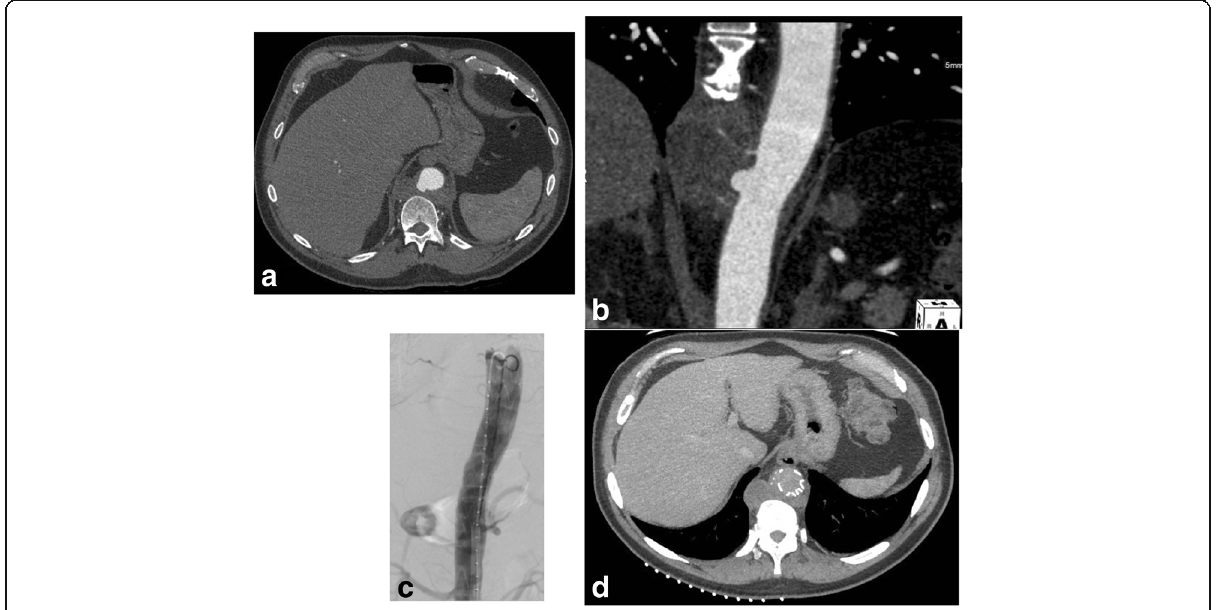
Fig. 1 Sixty seven year old male with mycotic aneurysm of the thoracic aorta. a Axial and b coronal images show enhancing, multiseptated, and lobulated low density mass within the lower retrocrural space/posterior mediastinum that abuts the adjacent thoracic aorta along 180 degrees of contact. Focal outpouching of the descending thoracic aorta at this site is consistent with a psuedoaneurysm. c Post stent graft deployment angiogram and d CT show satisfactory placement of the stent graft with no residual psuedoaneurysm or post procedural